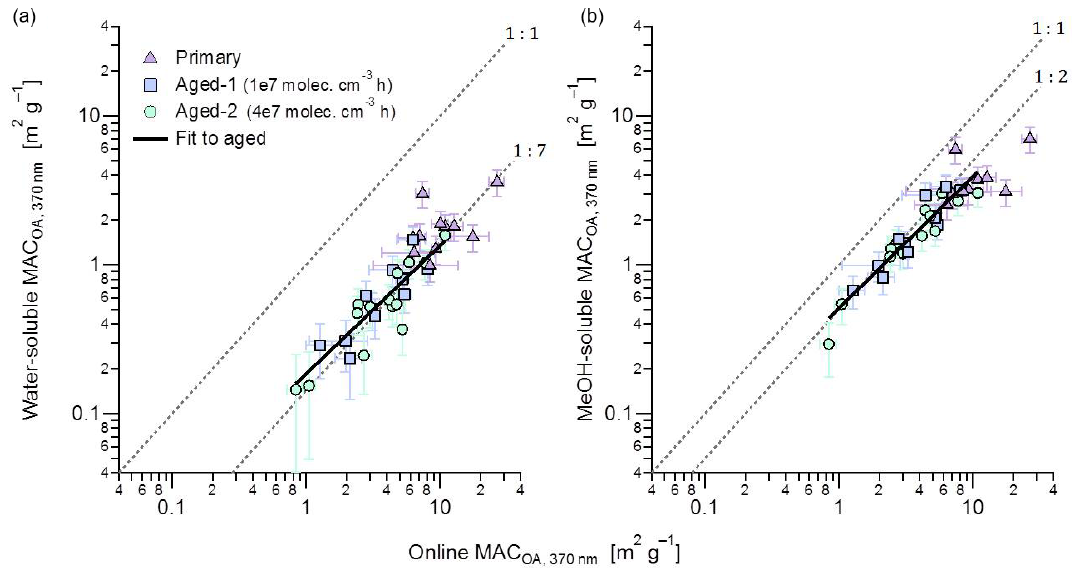
Figure 6. Comparison of the MAC OA (370nm) of aged aerosols determined from online and offline absorption measurements. The offline filter-extraction method directly quantified properties of total OA (ordinate), while the average of MAC SOA and MAC POA weighted with respective mass concentrations is shown on the abscissa. The panels show offline measurements of (a) water-soluble OA and (b) methanol- soluble OA. Fits are to aged data only due to the significantly smaller scatter of those data, although primary data on average follow similar trends. The fitted slopes and intercepts are, respectively, (a) 0 . 13 ± 0 . 02 and 0 . 05 ± 0 . 06m 2 g − 1 and (b) 0 . 12 ± 0 . 1 and 0 . 38 ± 0 . 03m 2 g − 1